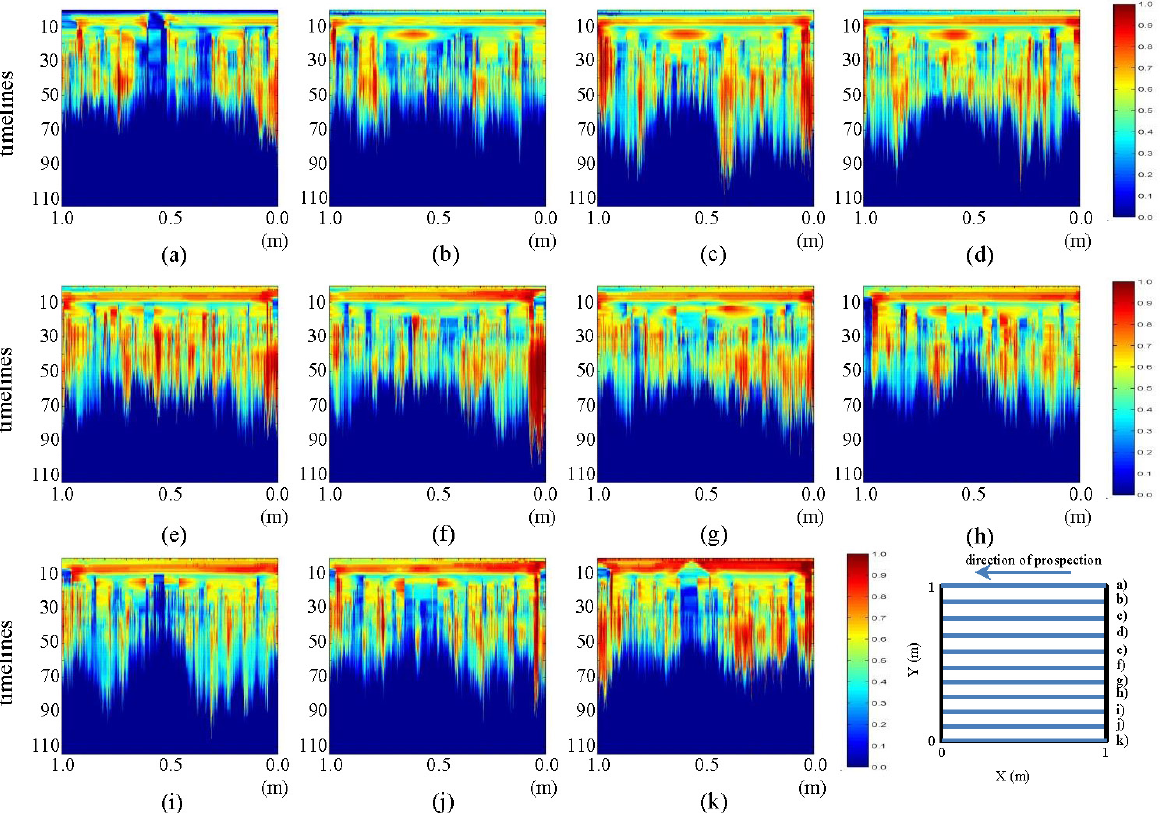
Figure 15. Horizontal profiles: pre-processed images for the final state. ( a – k ) are profiles s1 to s11,